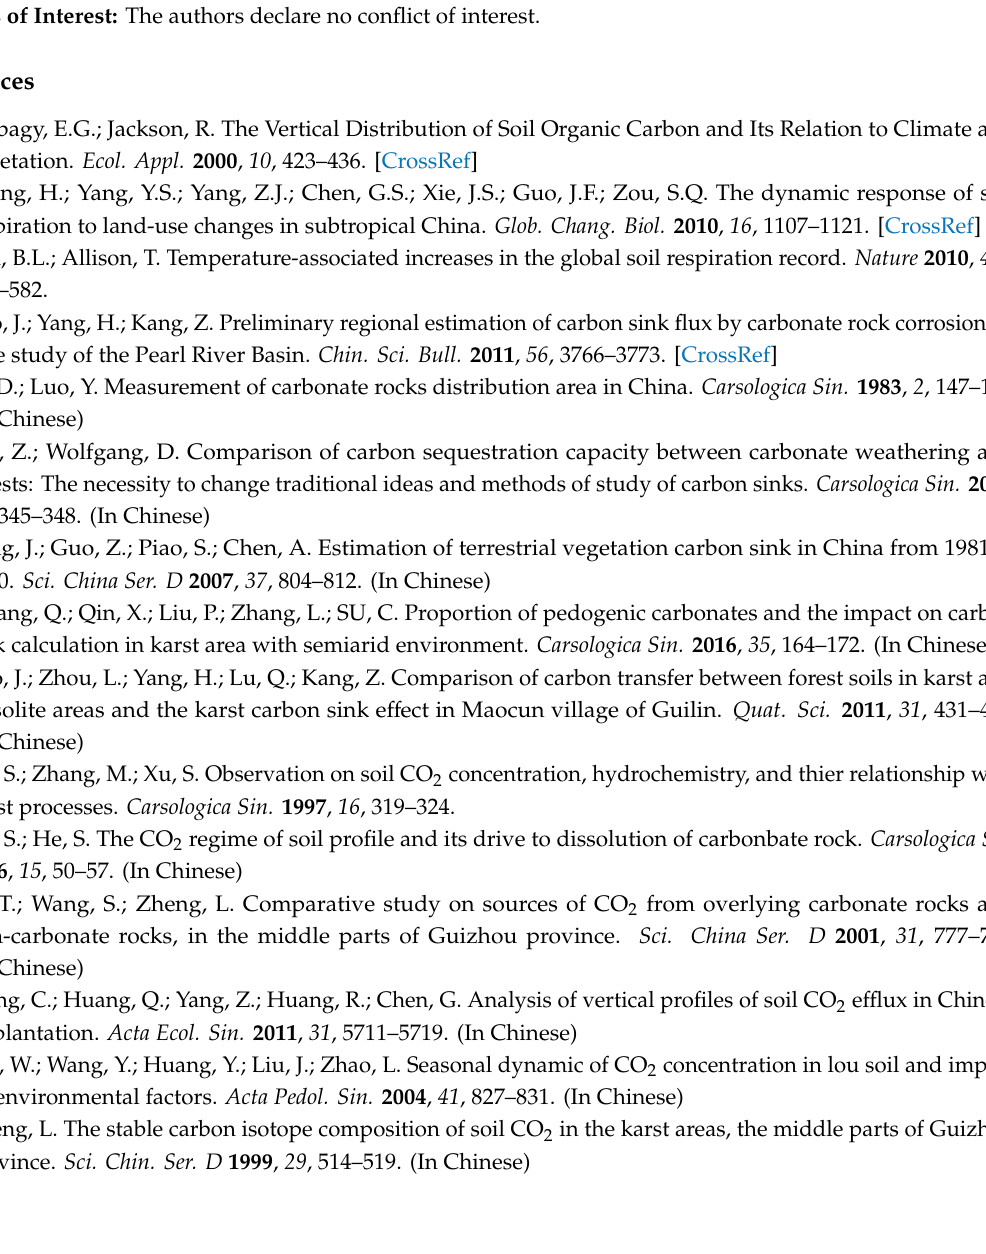
Figure S1: Temperature and rainfall in Maocun village, Table S1: Respiration rates in calcareous and red soils, Table S2: CO 2 Concentrations in di ff erent layers in calcareous and red soils, Table S3: δ 13 C-CO 2 values at di ff erent depths of calcareous and red soils, Table S4: Seasonal carbonate dissolution rates in calcareous and red